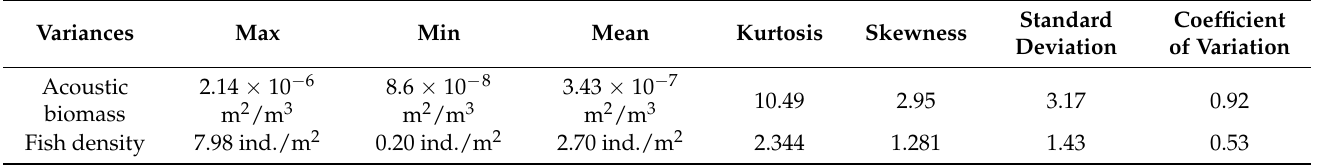
Table 4. Classical statistical of acoustic biomass and fish density.